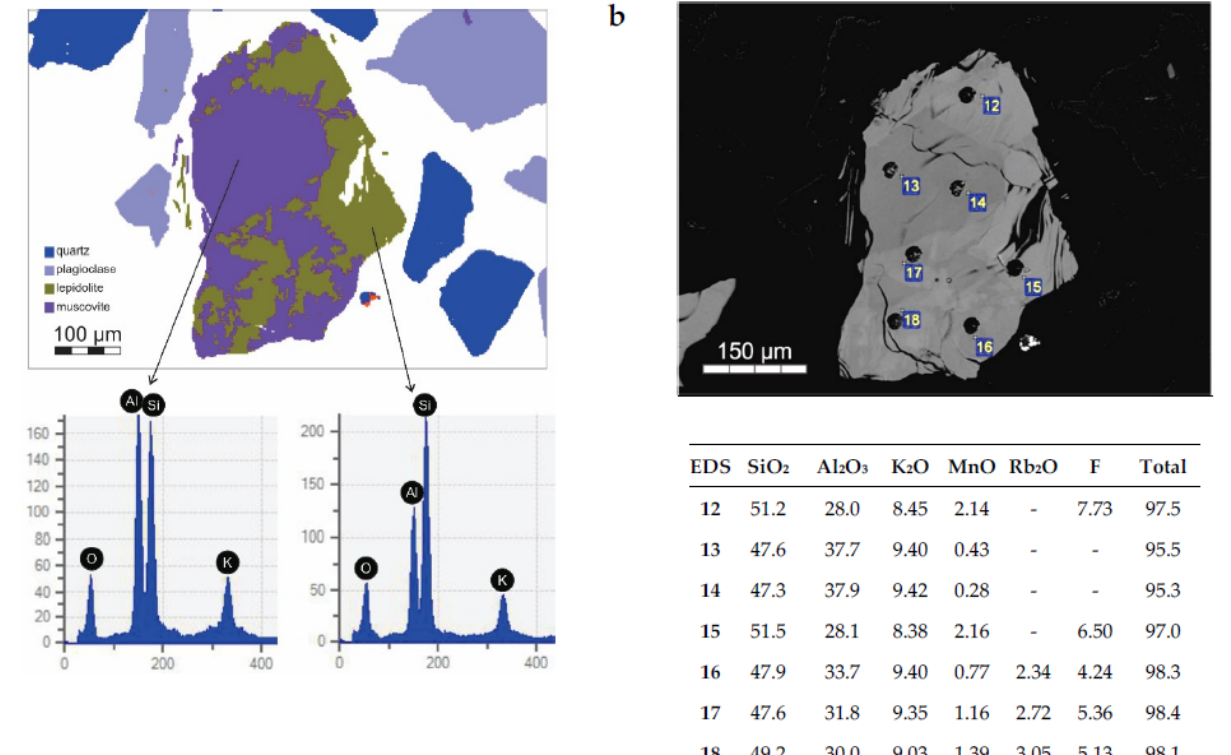
Figure 11. SEM-IA particle composition map illustrating the X-ray spectrum of each classified phase ( a ) and the BSE image of the same particle depicting the EDS analysis results for each mineral phase ( b ).